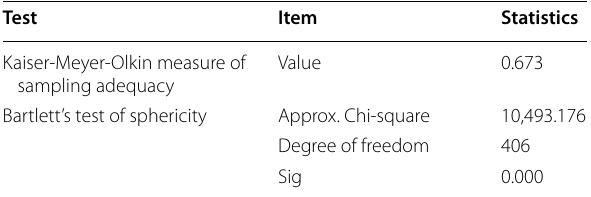
Table 3 Results of KMO and Bartlett’s test for SEV Test